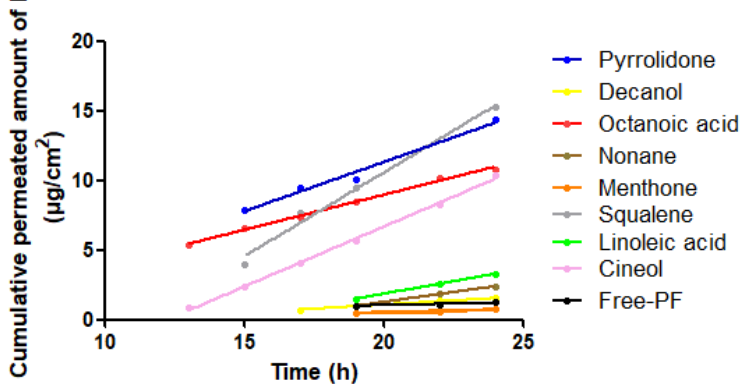
Figure 8. Median cumulative permeated amount of PF with and without penetration enhancers versus time (h) through human skin.